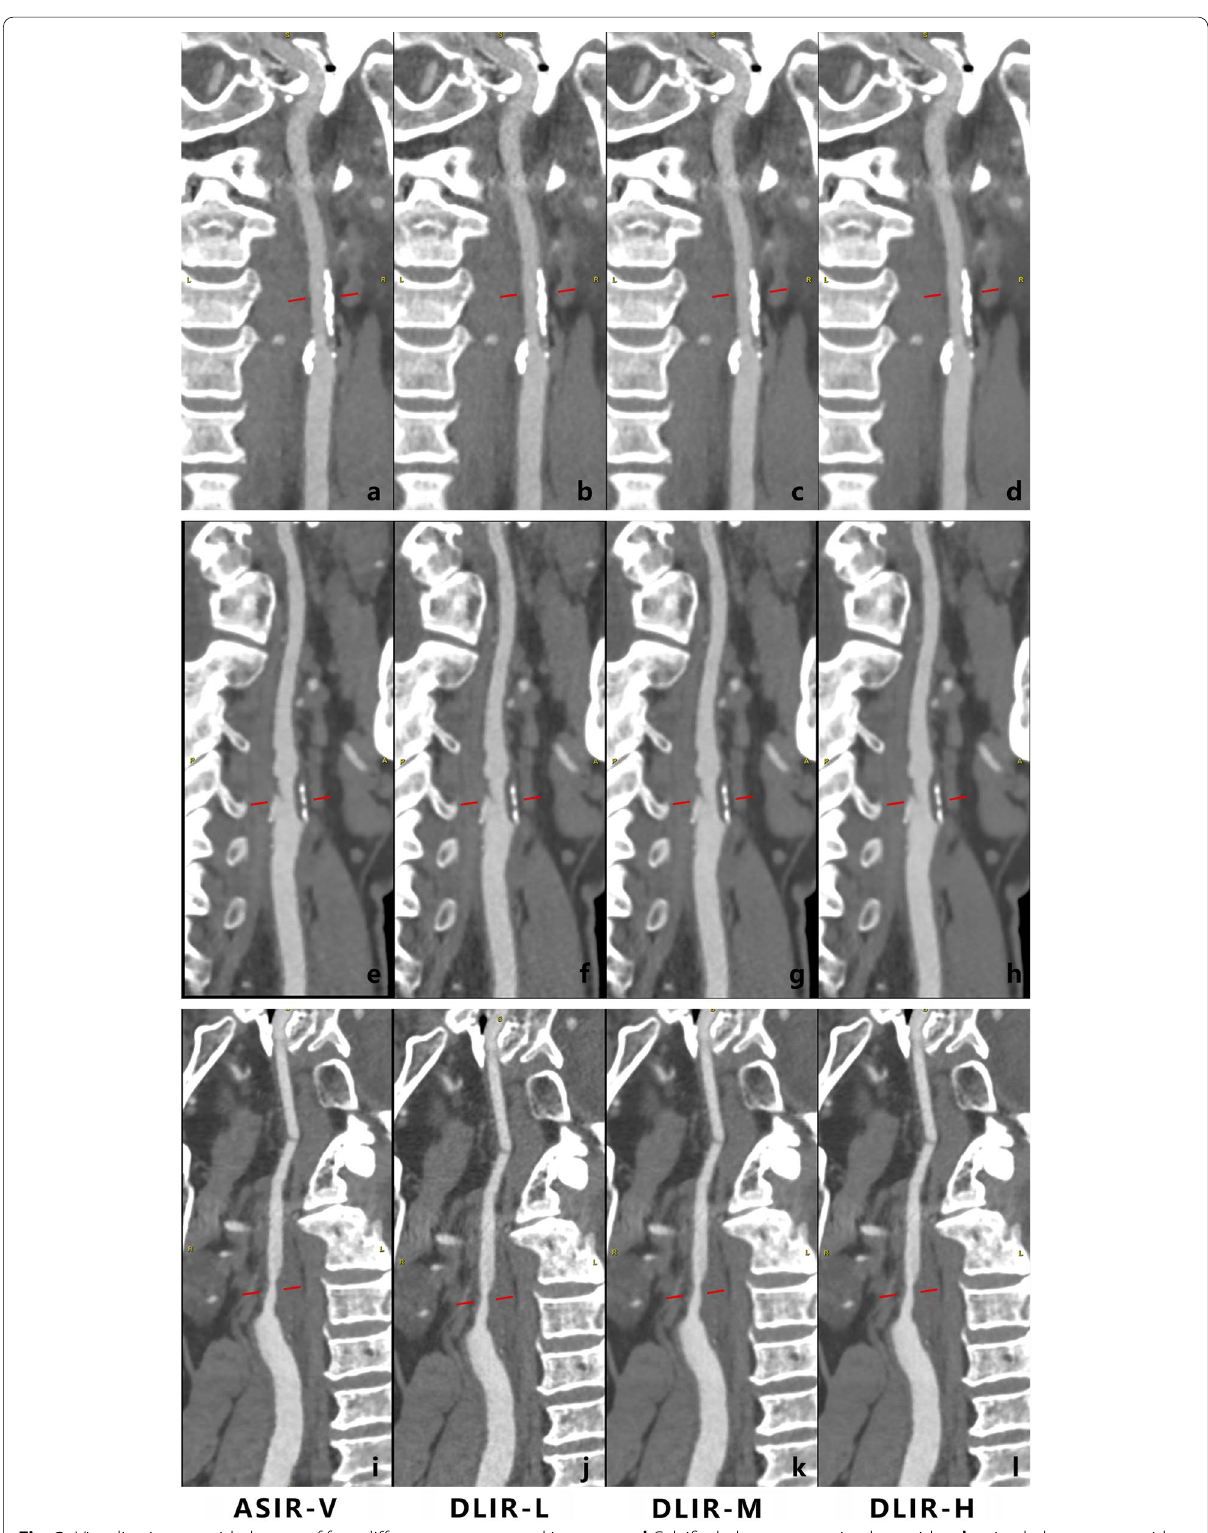
Fig. 3 Visualization carotid plaques of four different reconstructed images. a – d Calcified plaque at proximal carotid; e – h mixed plaque at carotid bifurcation; i – l non-calcified plaque at carotid bifurcation. The visualization of plaque composition and the estimation of stenosis gradation were almost identical between 80% ASIR-V and DLIR at all strength